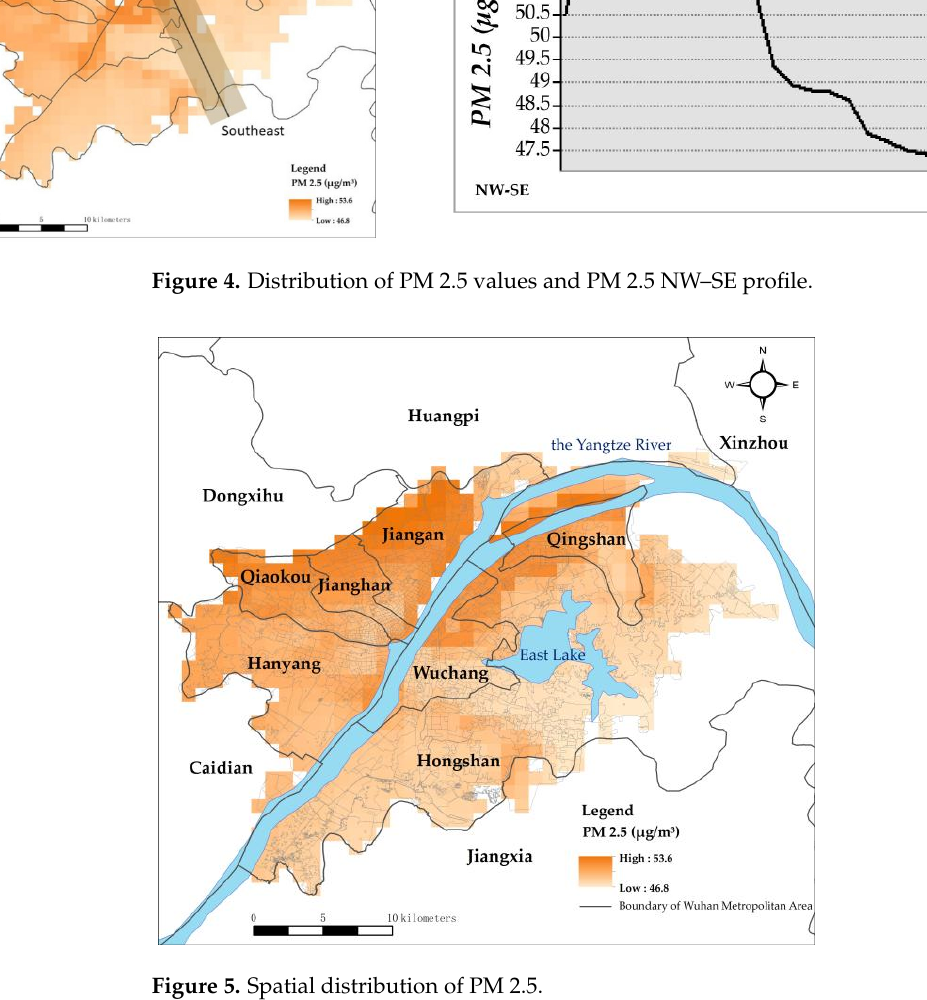
Figure 5. Spatial distribution of PM 2.5.